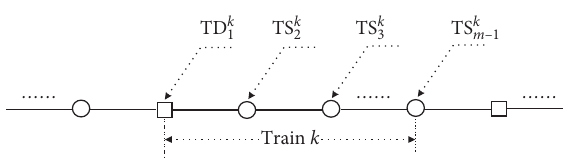
Figure 6: Chromosome